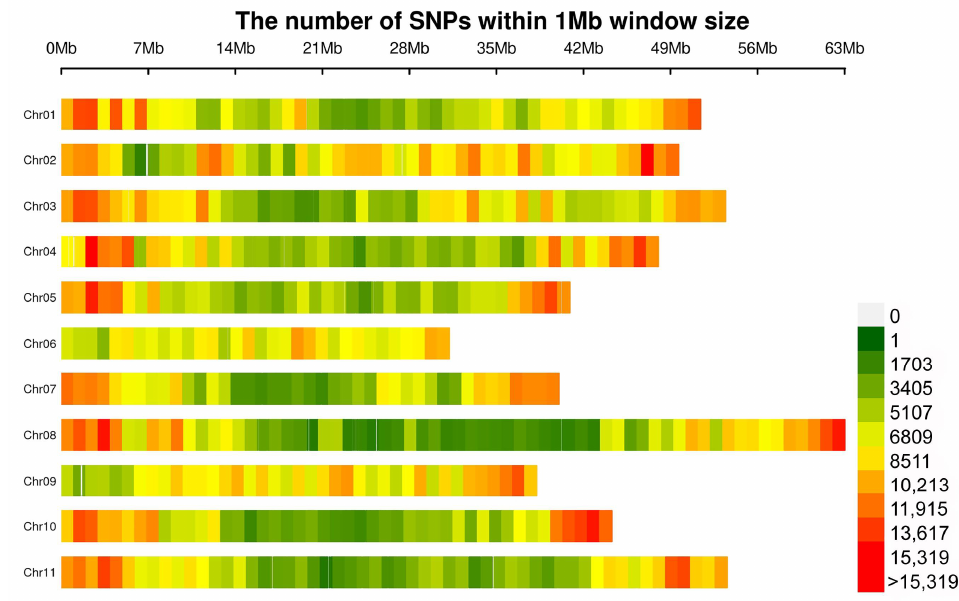
Figure 1. Histograms of pod suture strings in 138 snap bean accessions. ( A ) The ratio (string length/pod length) was measured in 2019. ( B ) The rating (1 for the presence of a string and 0 for the absence of a string) was determined in 2019. ( C ) The ratio was measured in 2020. ( D ) The rating was determined in 2020. ST1: the ratio of string length to pod length; ST2: the rating of whether there are strings (1 for the presence of a string, and 0 for the absence of a string).